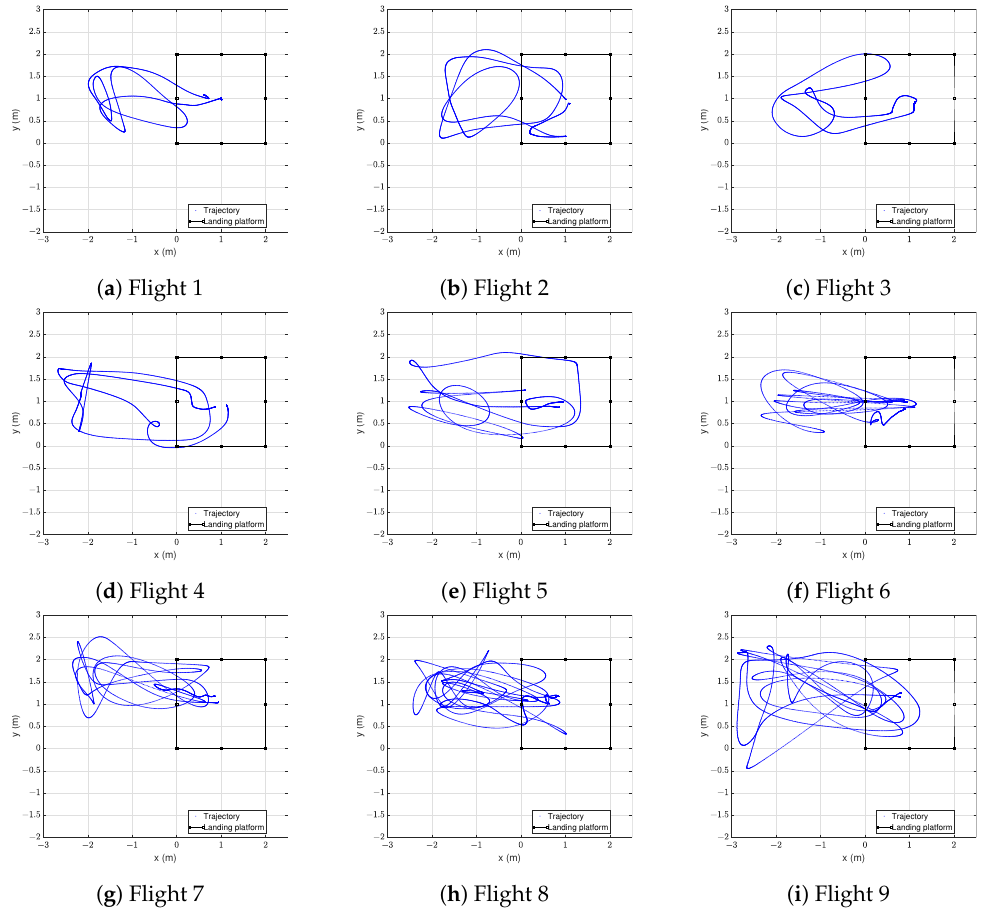
Figure 8. Horizontal trajectory of each flight. Blue line represents the movements of the drone and the black-edged square the landing platform.